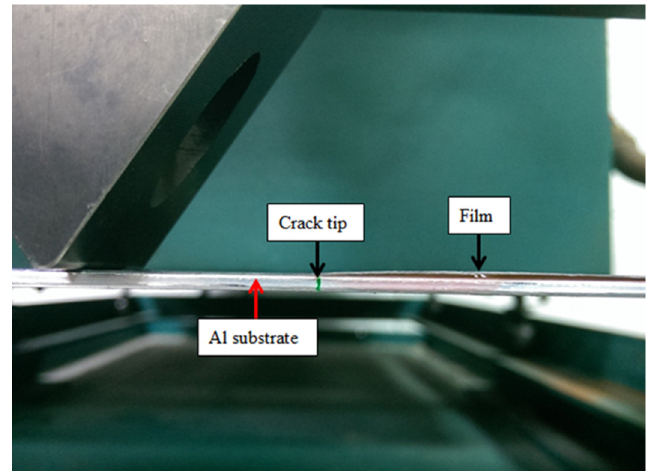
Figure 10. Configuration of nanocomposite film/Al substrate with interfacial edge crack.